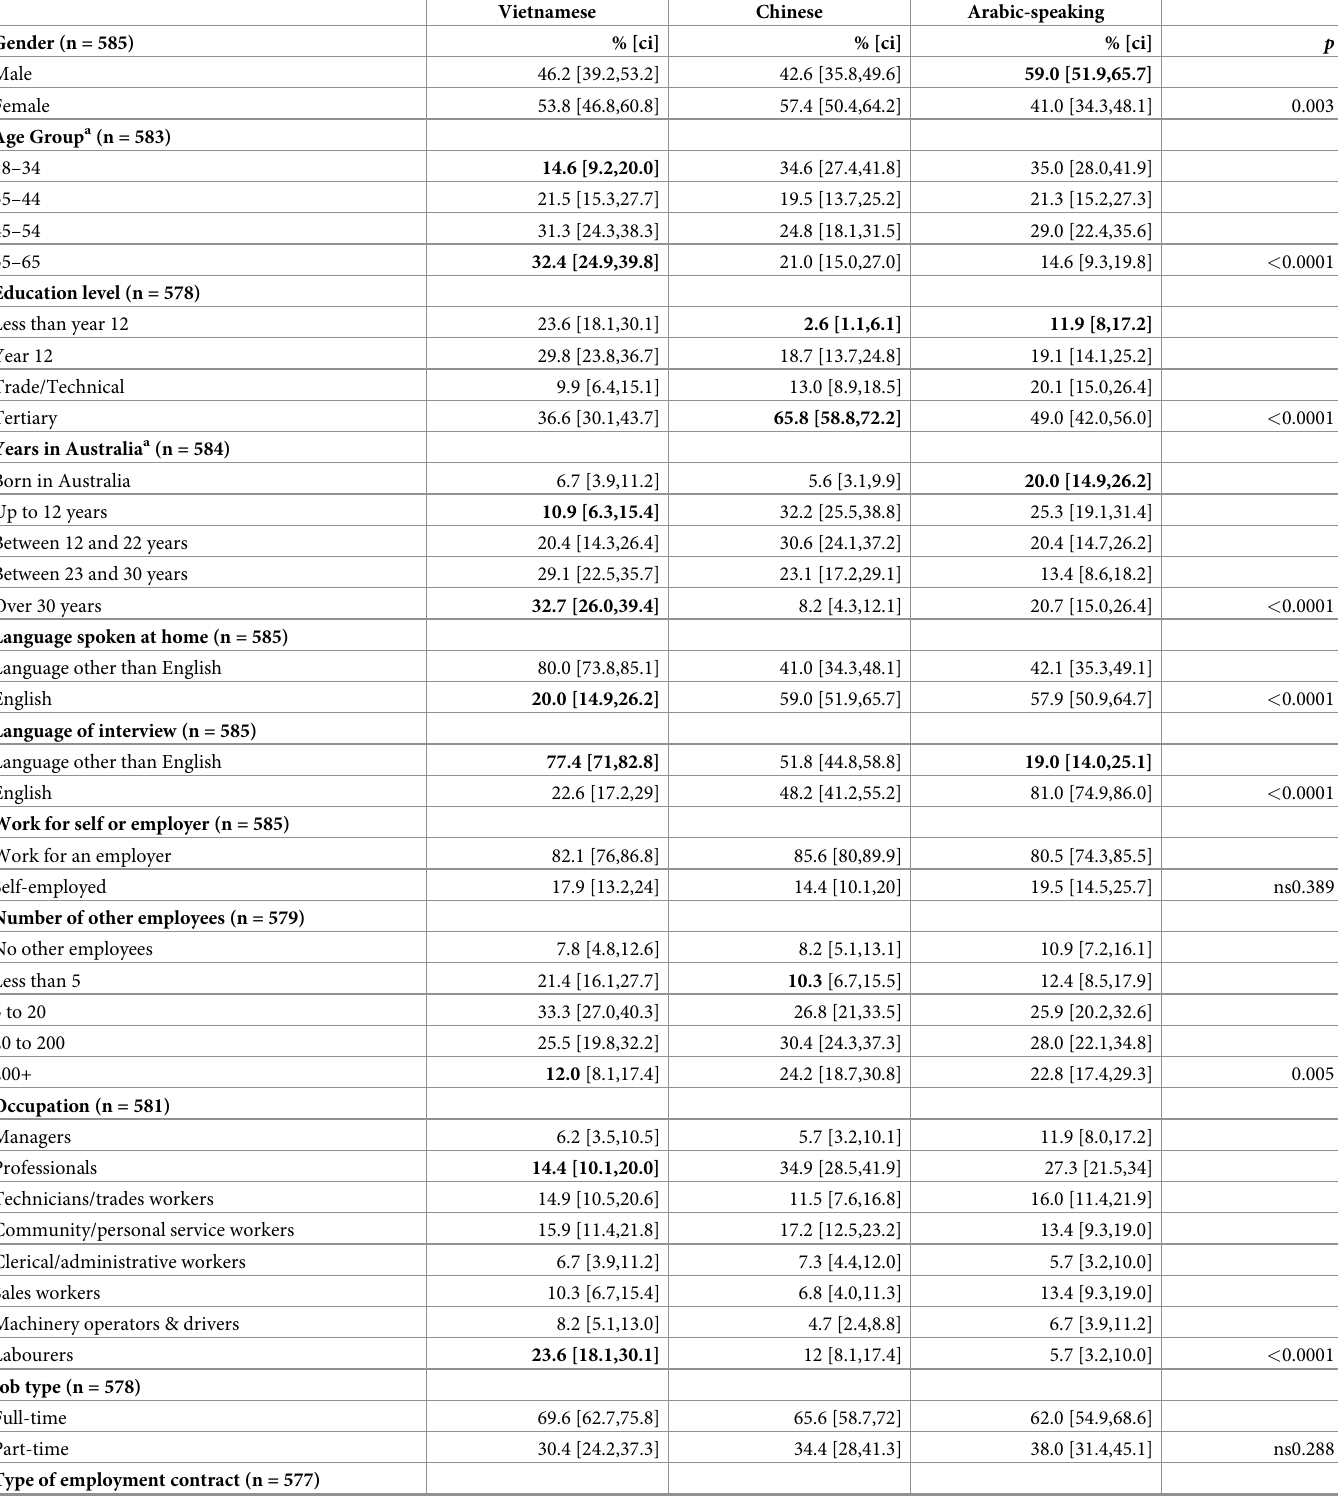
Table 1. Prevalence of demographic and employment characteristics among migrant workers in Australia, General Ethnic Discrimination Survey